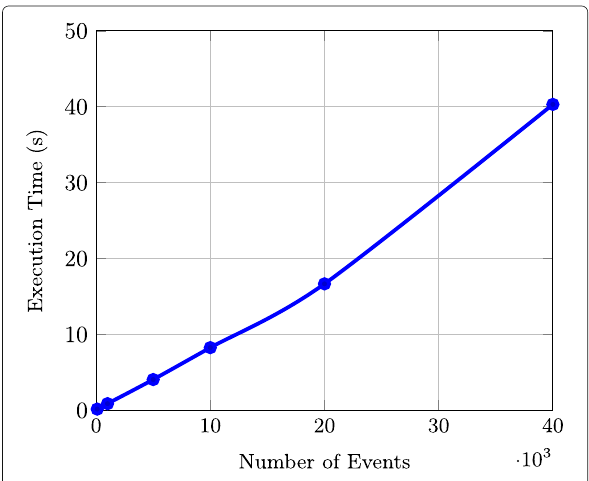
obtained are much worse for any length of sequence in the pheronome-free case.